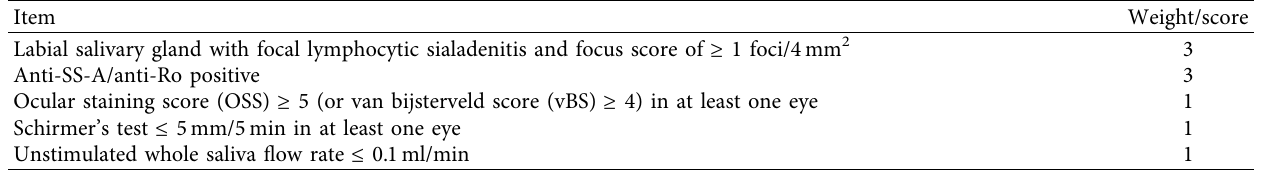
Table 4: 2016 classification criteria for primary SS by ACR/EULAR